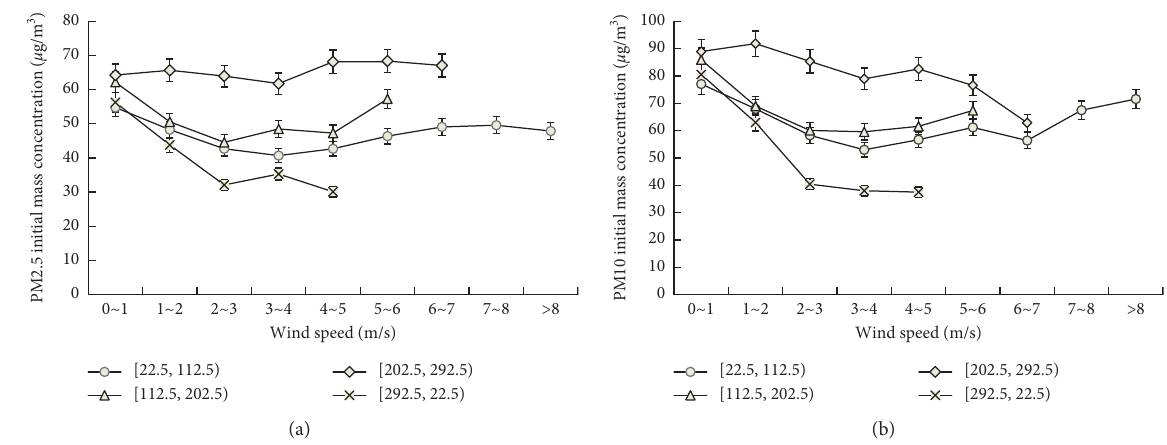
Figure 15: PM2.5. (a) PM10. (b) Mass concentration variation under different wind speed and wind